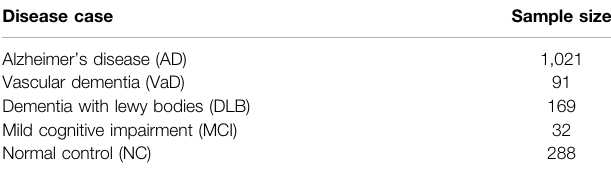
TABLE 1 | Sample size for normal control and four neurodegenerative diseases. Disease case Sample size Alzheimer ’ s disease